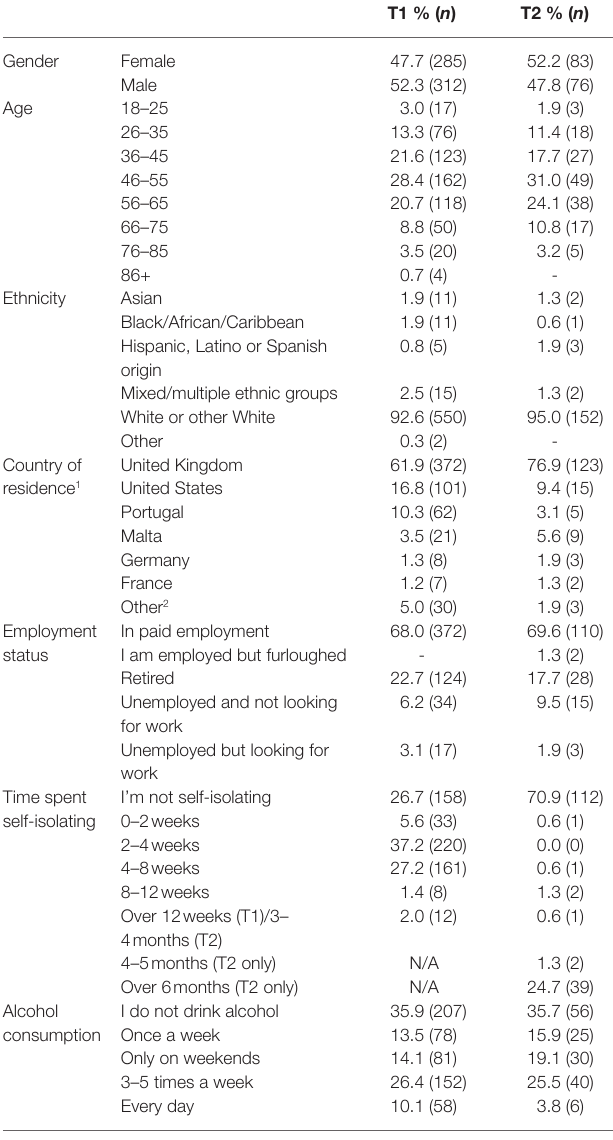
TABLE 2 | Sample characteristics at T1 and